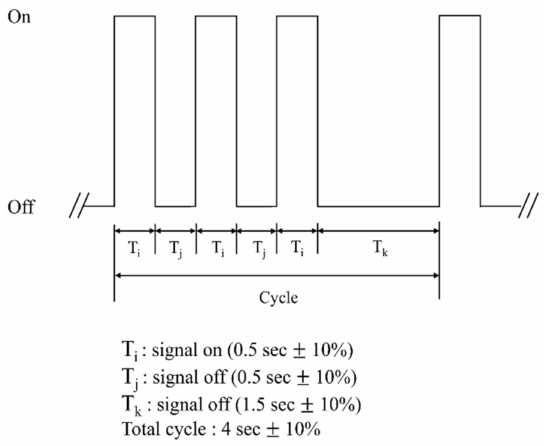
Figure 1. An example of temporal three (T-3)